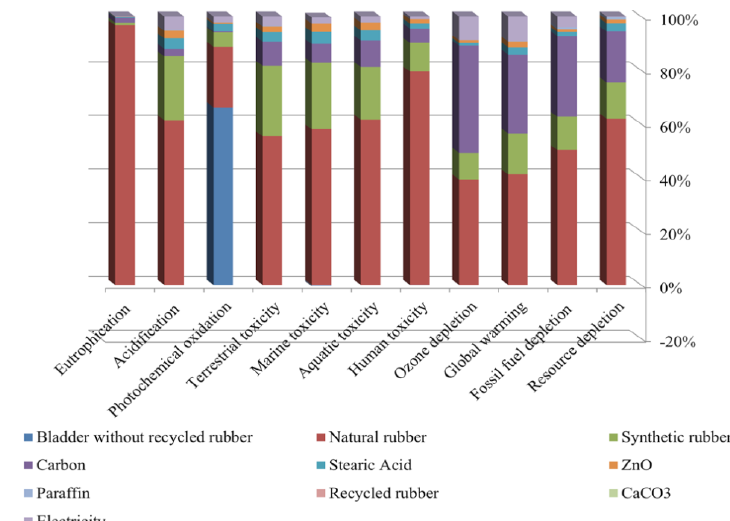
Figure 2. Environmental flow of 1 Kg of ball bladder produced without recycled rubber